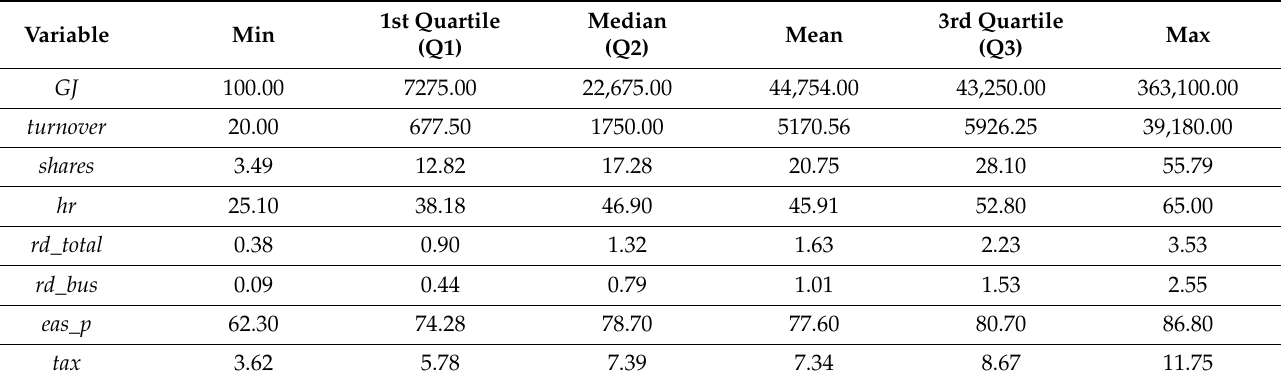
Table 2. Summary of descriptive